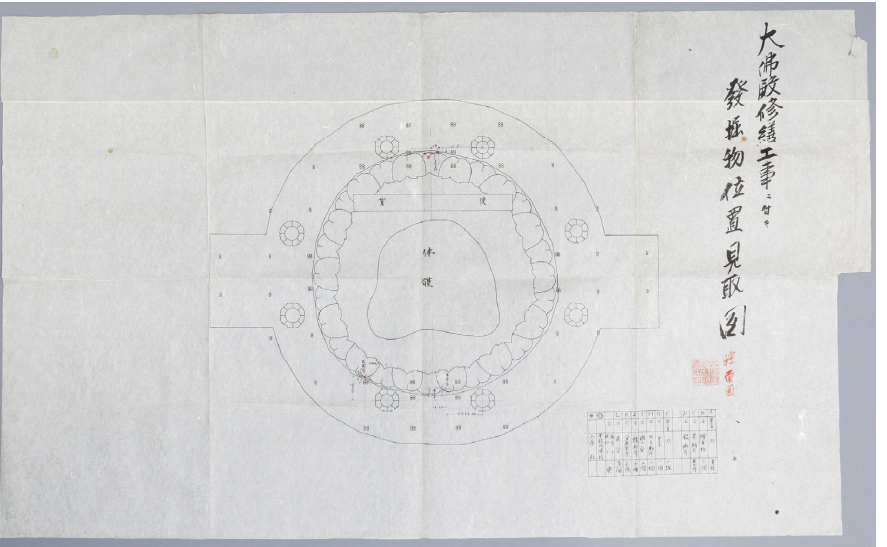
Figure 2. Layout of the objects discovered during the restoration of the Great Buddha Hall. Meiji period, 1907 or 1908. In the collection of Tokyo Geijutsu Daigaku Bijutsu Gakubu Kingendai